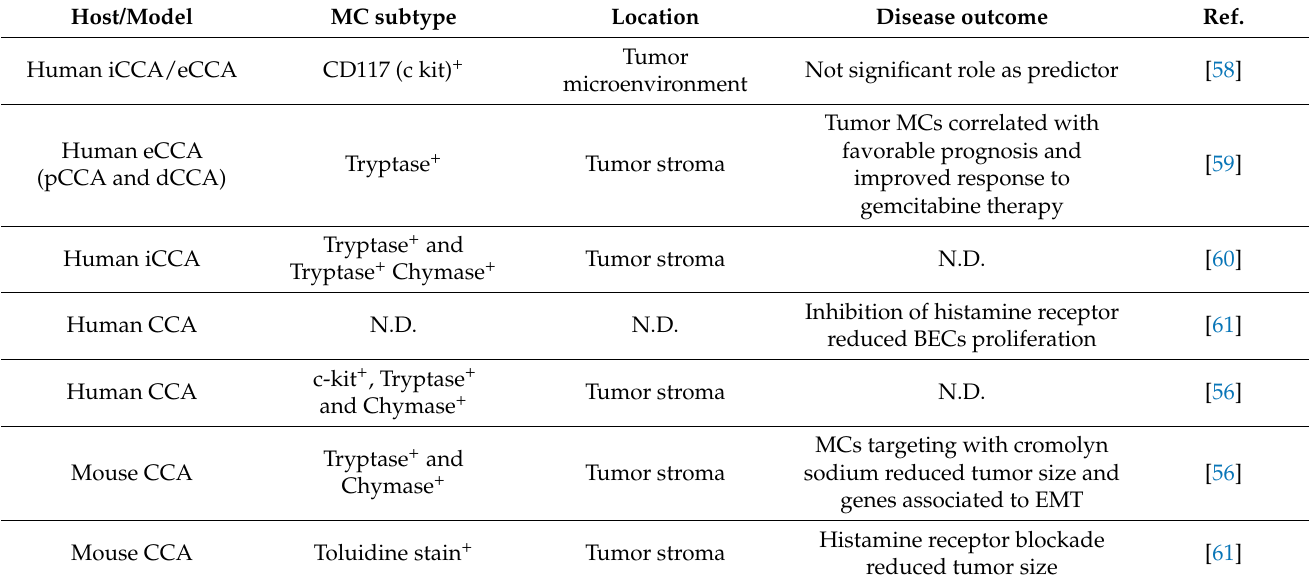
Table 2. Diverse roles of MCs in